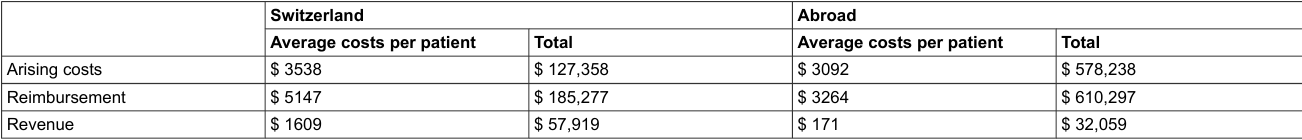
Table 2: Average and total costs of cases from Switzerland and abroad.